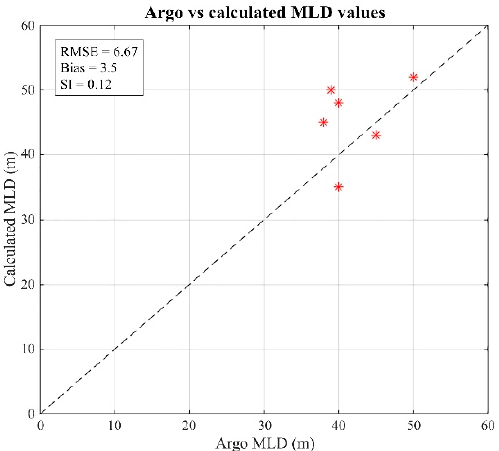
Figure 8. Comparison of measured MLD by Argo floats at different locations and times with calculated MLD based on Equation (1).